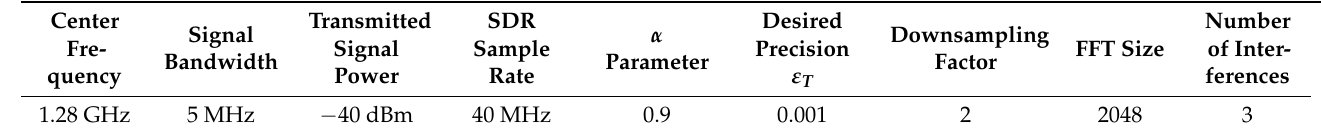
Table 2. Parameters used for the practical test.